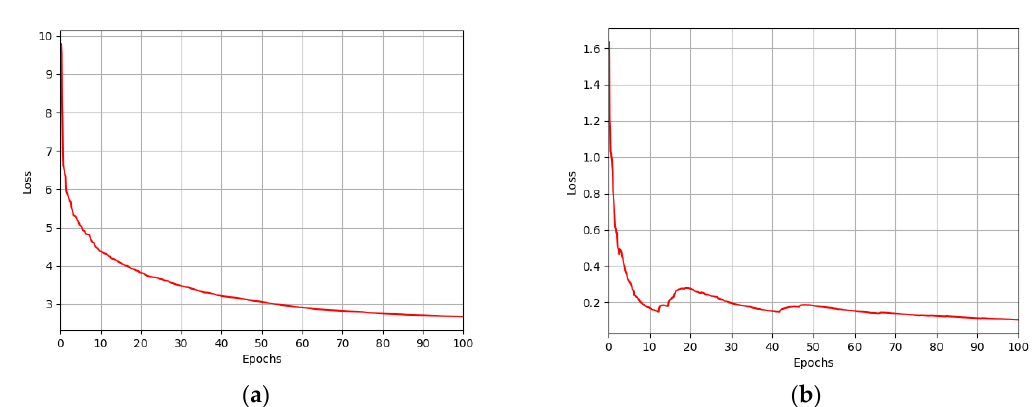
Figure 6. Graphs of LAE-GAN losses. ( a ) Generator loss and ( b ) discriminator loss.